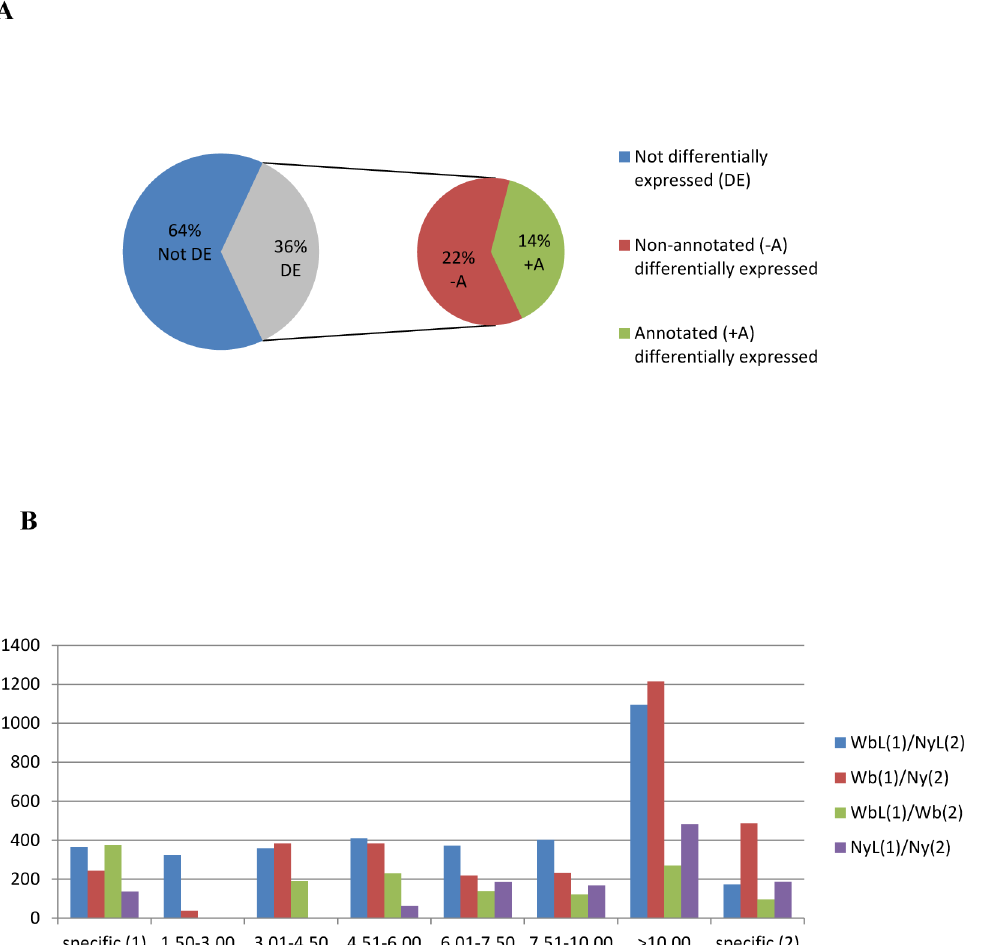
Fig 2. The number and distribution of differentially expressed ( p < 0.05) contigs for CLas-infected (L) and uninfected (no label) adults (Wb) and nymphs (Ny) of the Asian citrus psyllid (ACP). Pairwise comparisons were carried out for the following combinations: adults, uninfected and infected (Wb x WbL), nymphs, uninfected and infected (Ny x NyL), uninfected adult and nymphs (Wb x Ny), and infected adults and nymphs (WbL x NyL). For each comparison, the term represents the first library in each respective comparison. The number 1 refers to: Wb, Ny, Wb, and WbL, and the number 2: refers to WbL, NyL, Ny, and